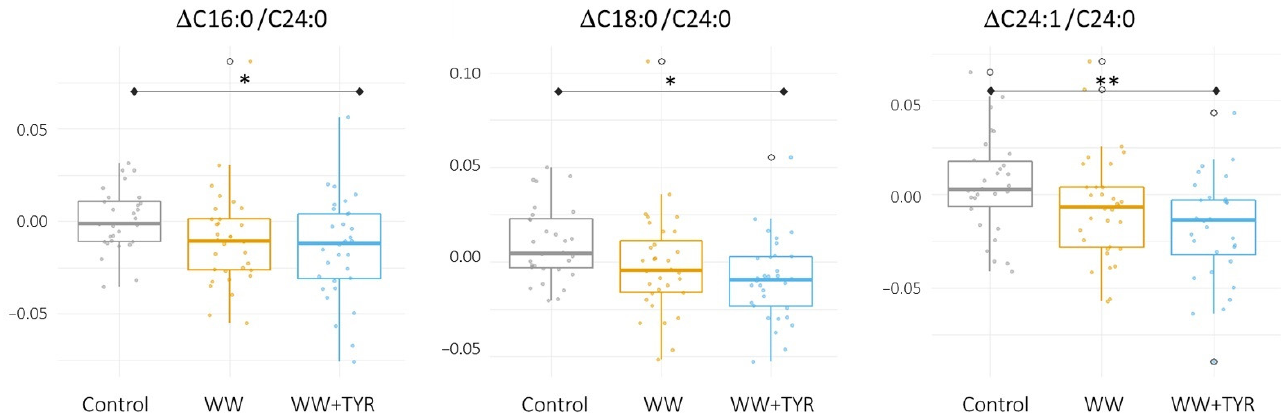
Figure 1. Changes in ∆ ceramides ratio (final vs. baseline) observed following each intervention of the clinical study. Changes in ∆ ceramides ratio (final vs. baseline) observed following each intervention. Statistical differences found between Control and WW + TYR interventions in the ANOVA repeated measures adjusted by sex, age, BMI, smoking status, and statin treatment. * p value < 0.05; ** p value < 0.001.